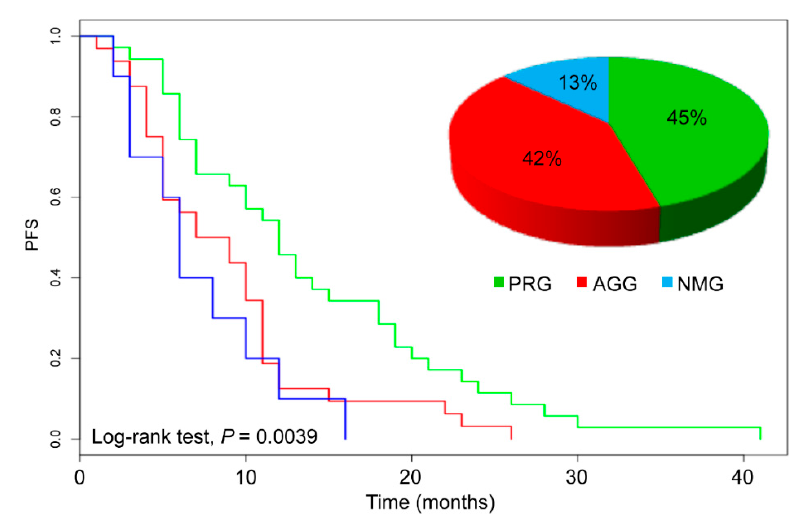
Figure 3. Kaplan–Meier plot showing the impact of p53/RAS Group (PRG; green), All Genes Group (AGG; red) and No Mutations Group (NMG; blue) group stratification on progression free survival (PFS) in the mCRC cohort. Table 3. Univariate and multivariate analysis of predictors of PFS in the mCRC cohort. Univariate Cox Regression PFS